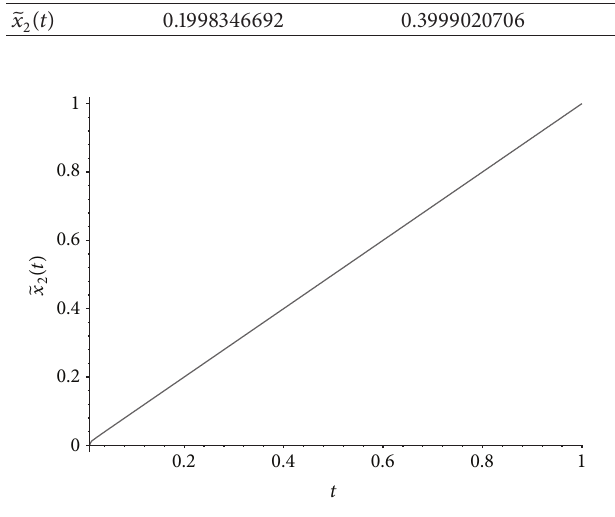
Figure 5: Approximation ̃𝑥 2 (𝑡) to the exact solution 𝑥(𝑡) = 𝑡 of the fractional problem of the calculus of variations (54)-(55), obtained from the application of Theorem 7 and the classical Pontryagin maximum principle, that is, obtained by solving (67)-(68) with 𝑁 = 2